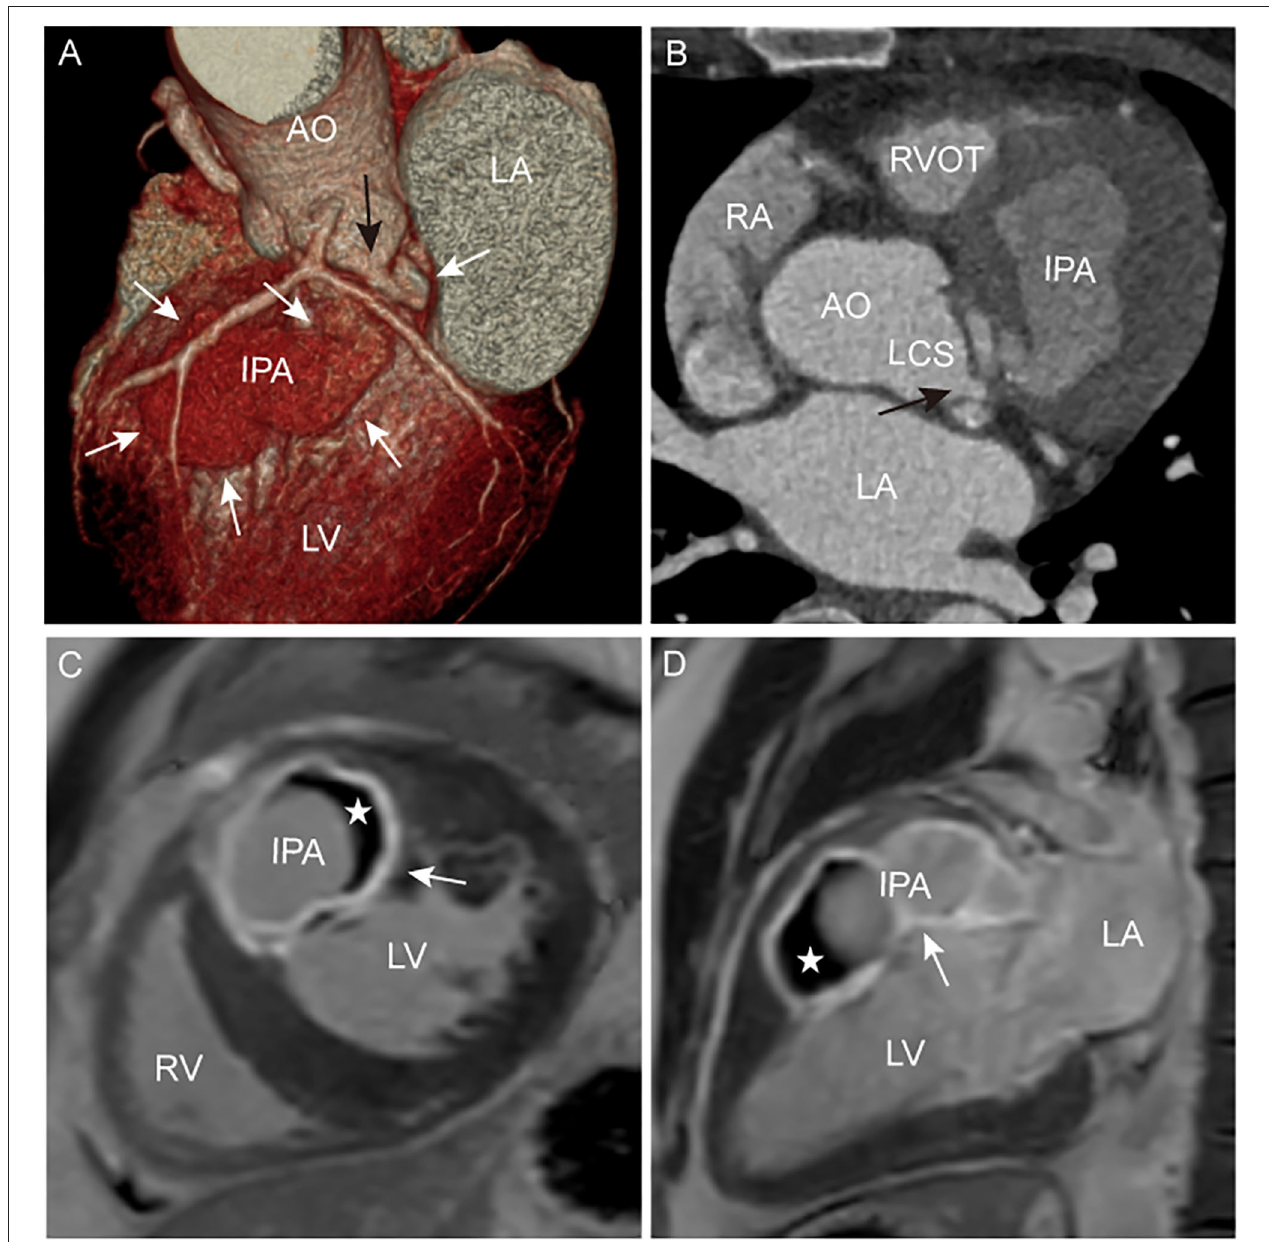
FIGURE 2 | (A,B) CT angiogram images showing the anatomical profile of IPA (white arrow) and perforation (black arrow). (C,D) CMR LGE images showing the high signal intensity of the IPA with a distal low signal intensity ( ☆ ), and a linear high signal intensity (white arrow) of the IPA wall and partitions. LCS, left coronary sinus.